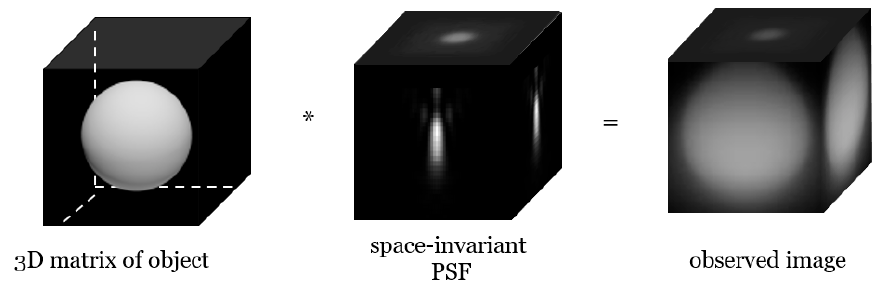
Figure 2. Calculation of the depth-invariant image model.